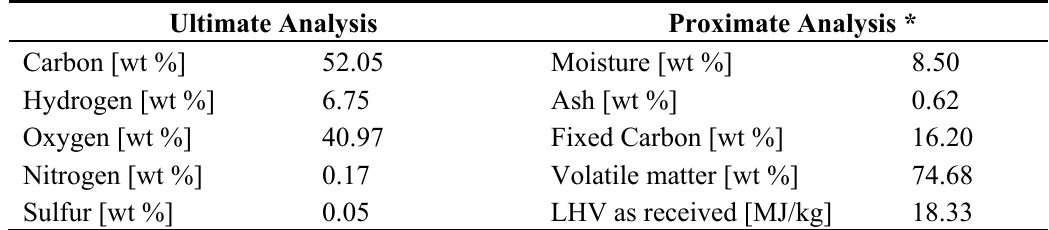
Table 1. Ultimate and Proximate Analyses of the Fuel Employed (* according to standards ISO 589:2008, ISO 562:2010 and ISO 1171:2010).